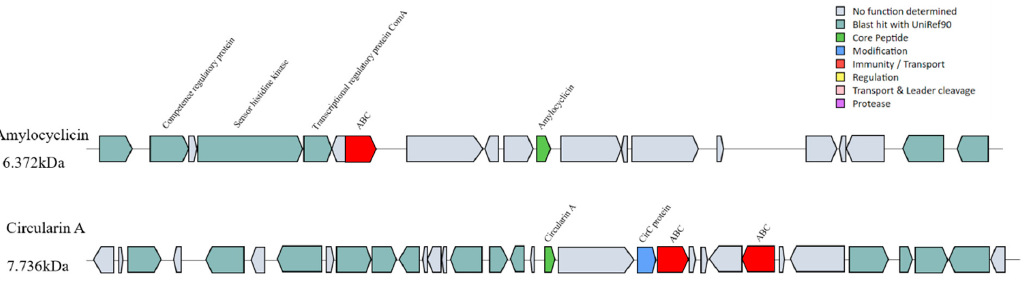
Figure 6. Bacteriocin synthesis gene cluster predicted by BAGEL4. Two cluster-encoding genes re- lated to Circularin A and Amylocyclicin were identified in the W. coagulans PL-W